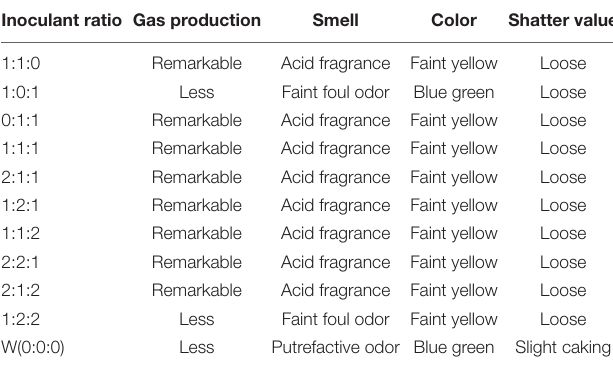
TABLE 2 | Evaluation of sensory profile of mulberry leaves silage obtained with different inoculant ratios presented by S. cerevisiae , L. plantarum , and B. subtilis in trial 1